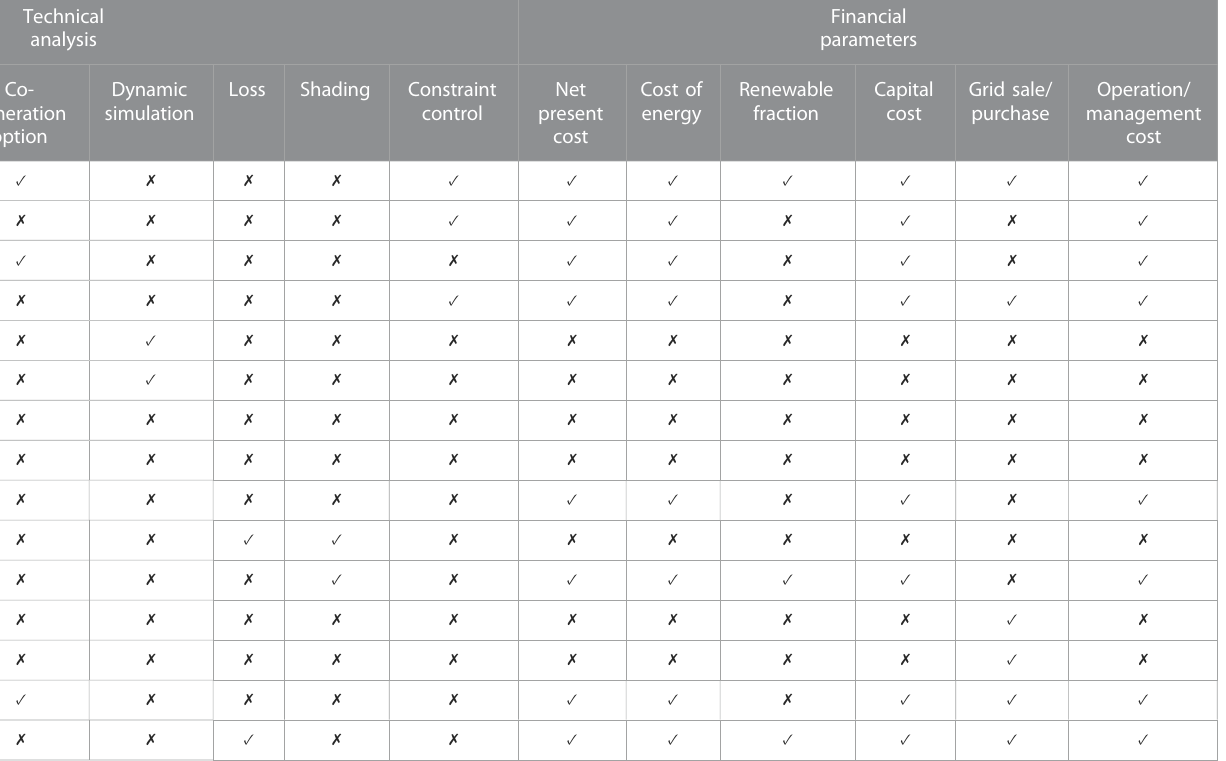
TABLE 6 A comparison of sixteen software illustrating the fundamental idea of important parameters and different analyses. Simulation tools